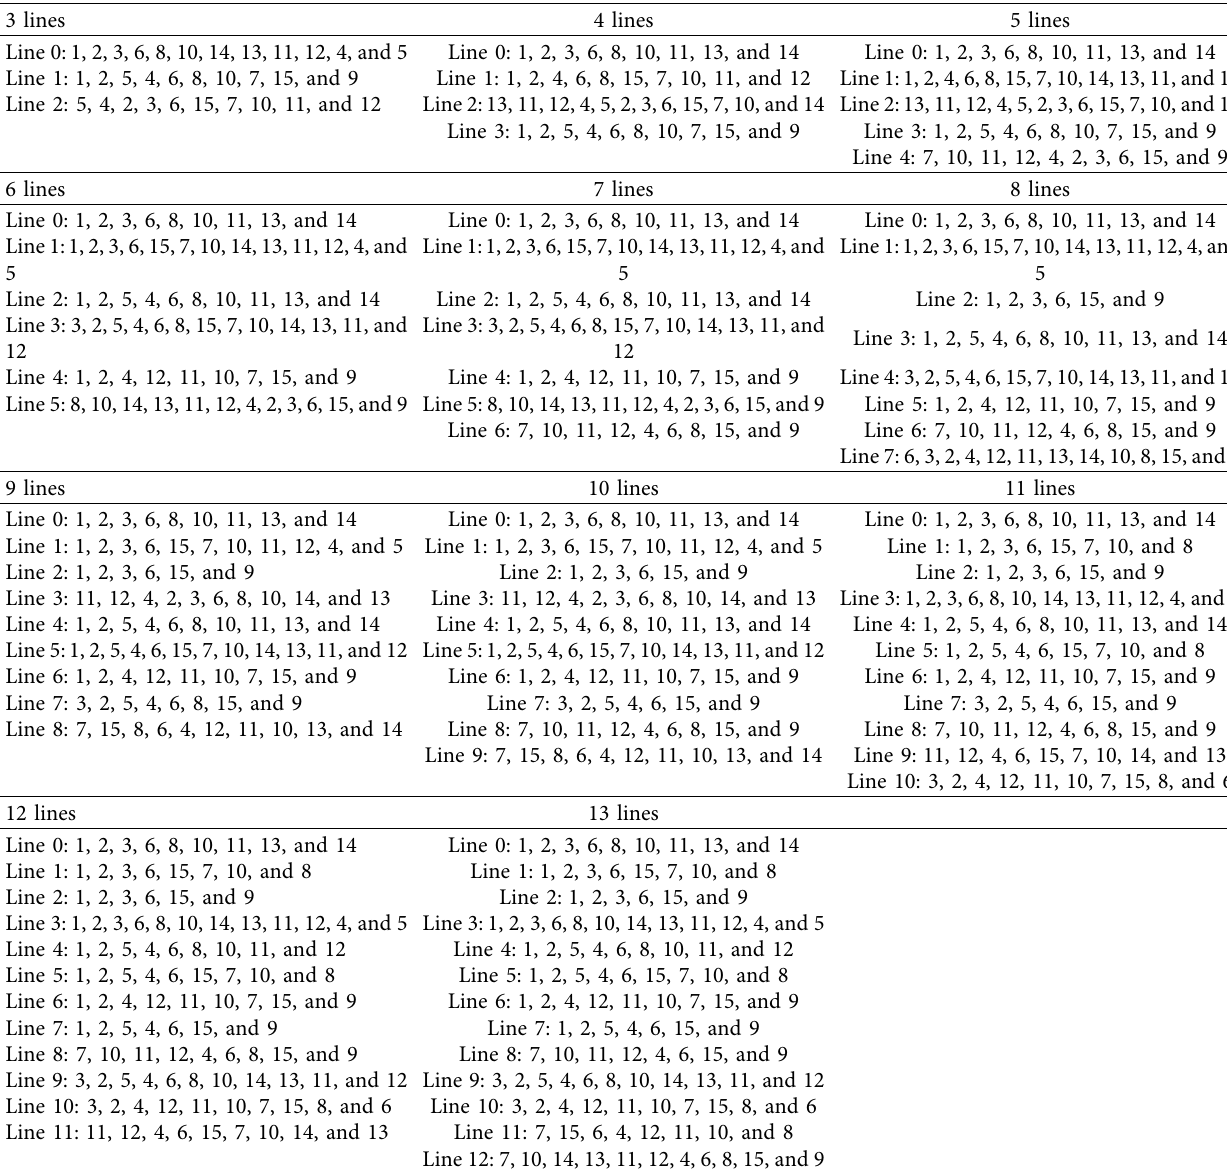
Table 4: Optimal solutions for 3 to 13 lines with at most 14 nodes per line.